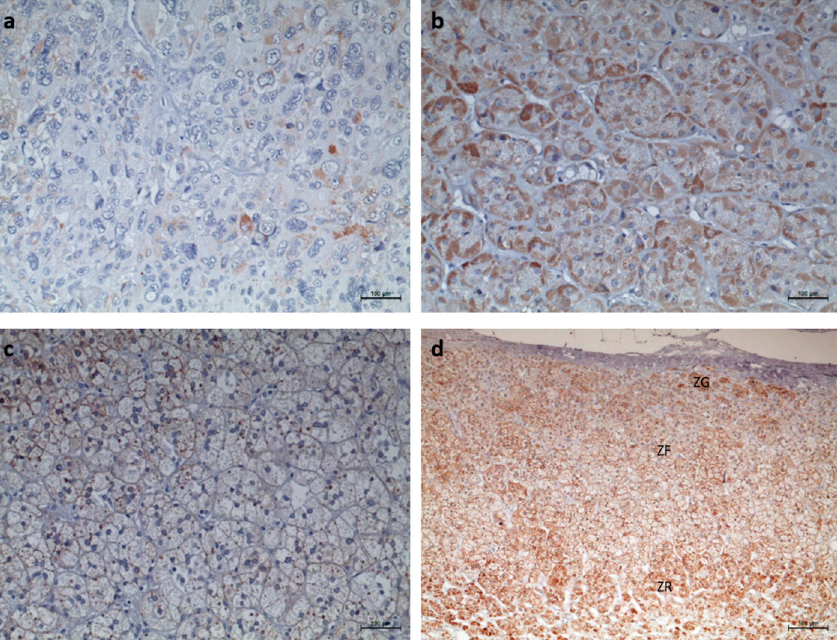
Figure 6. Immunohistochemistry staining for StAR (Scale = 100 μ m). ( a ) Adrenocortical carcinoma, ( b ) adrenocortical adenoma with Cushing’s syndrome, ( c ) non-functioning adrenocortical adenoma, and ( d ) normal adrenal gland. ZG – zona glomerulosa; ZF – zona fasciculata; ZR – Zona reticularis.